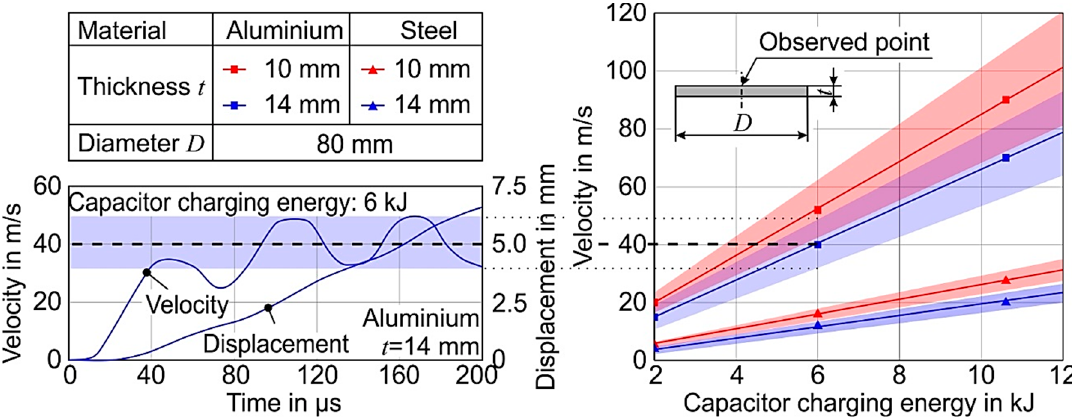
Figure 9. Velocities of electromagnetically accelerated hammers.